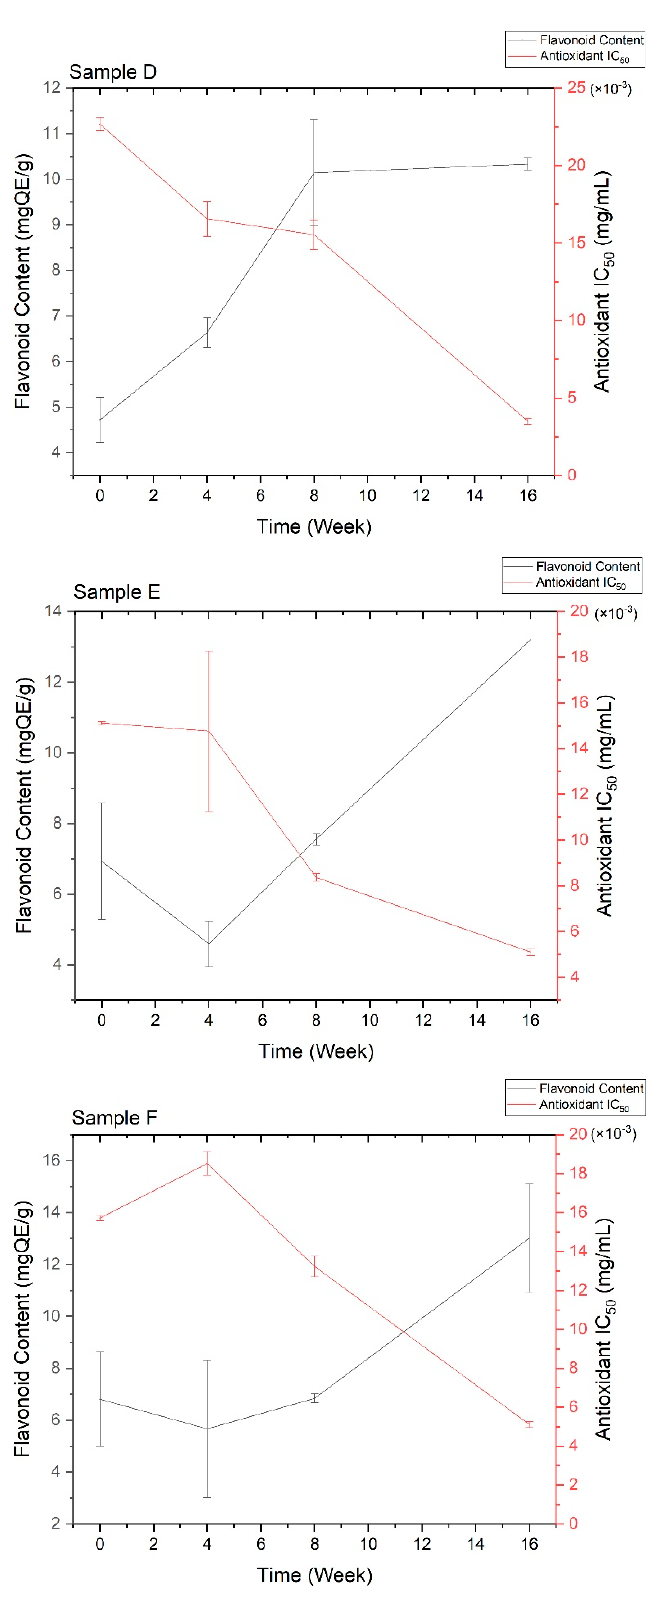
Figure 2. Correlation between quantitative flavonoid content and antioxidant activity of all stability test samples. The details of sample code refer to Table 1.